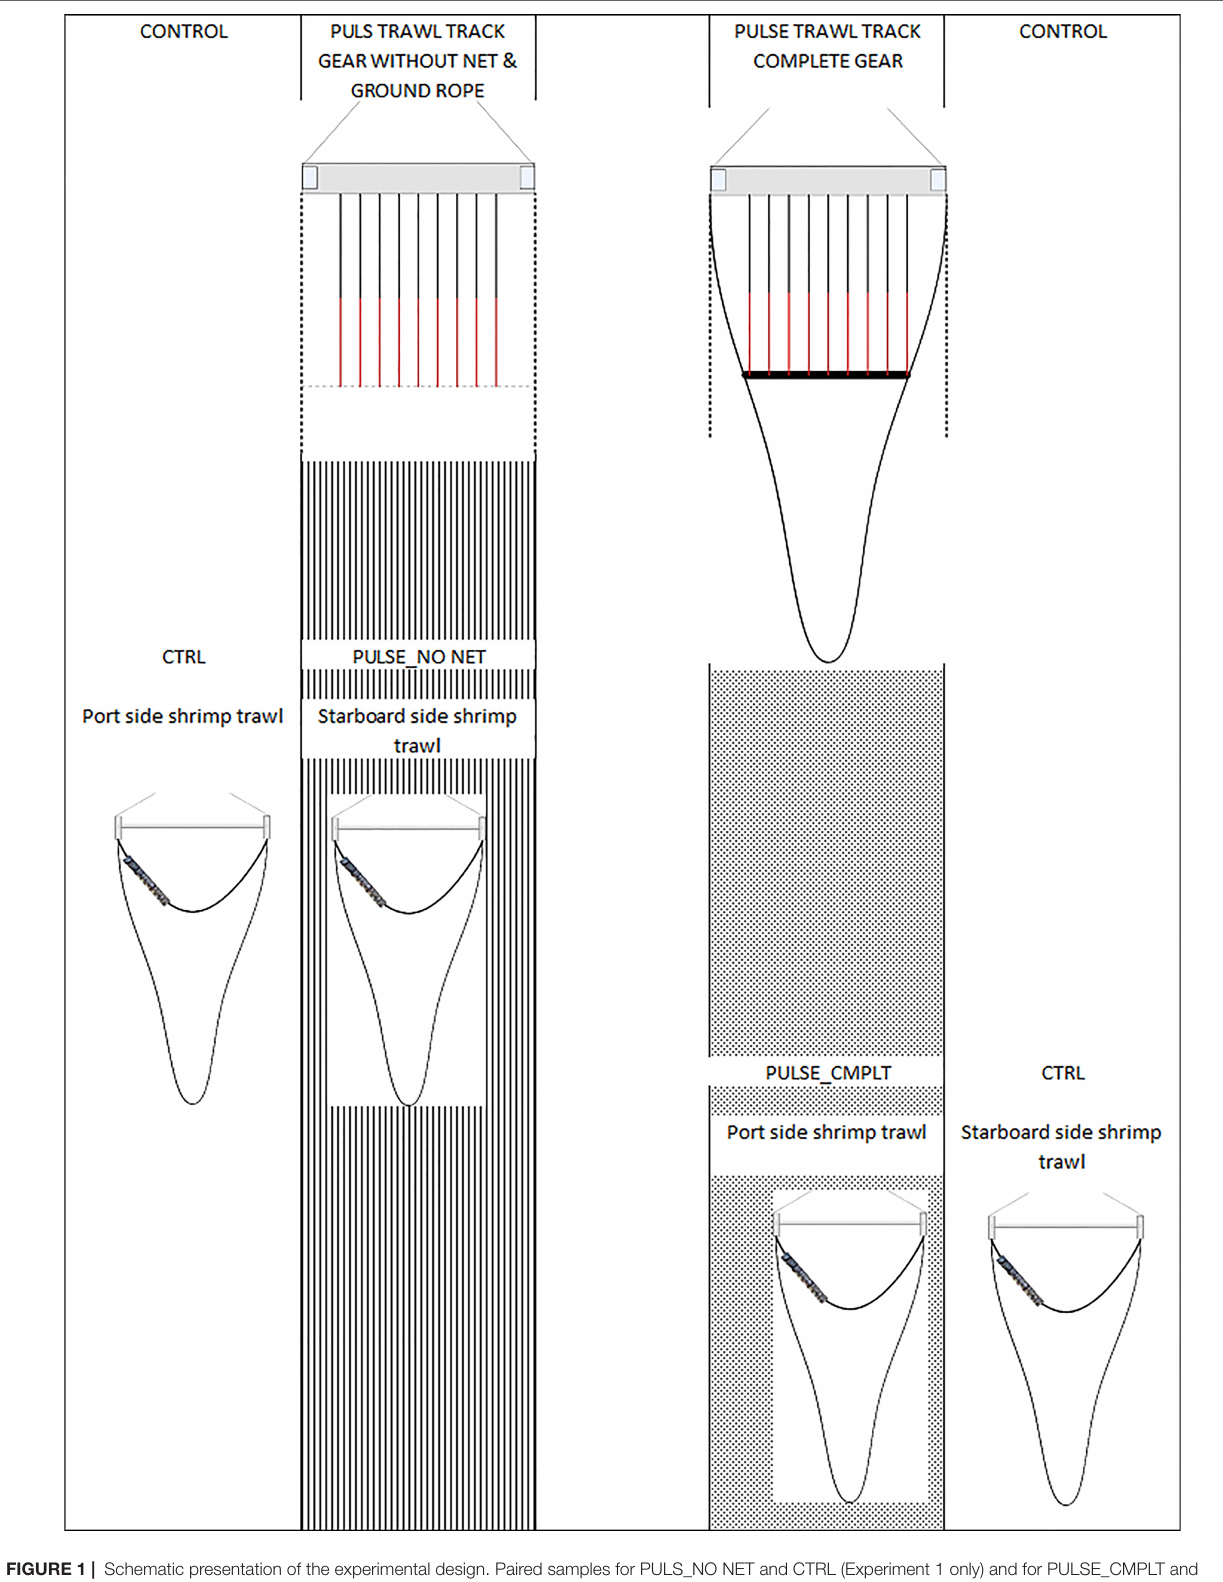
FIGURE 1 | Schematic presentation of the experimental design. Paired samples for PULS_NO NET and CTRL (Experiment 1 only) and for PULSE_CMPLT and CTRL (Experiment 1 and 2) were collected by deploying the shrimp trawls in and next to the respective pulse trawl